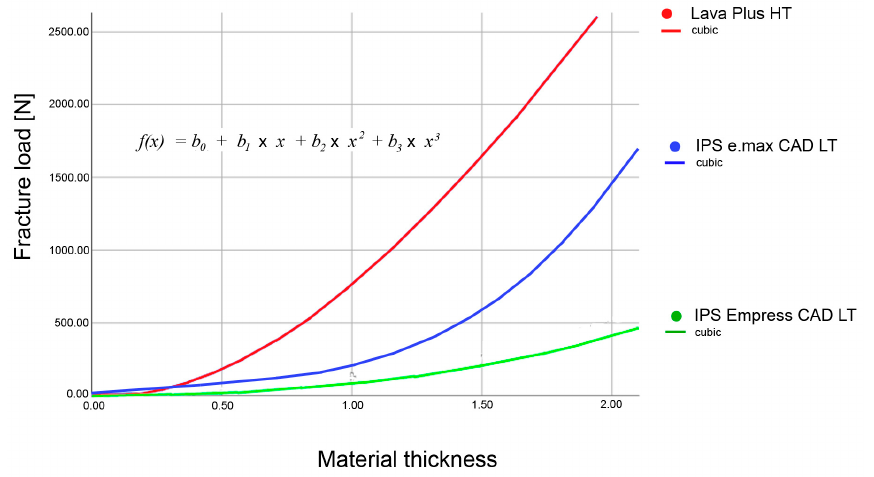
Figure 6. Regression curves of the fracture load values for the Lava Plus HT A2 (LU), with specimens in the five different material thicknesses examined.